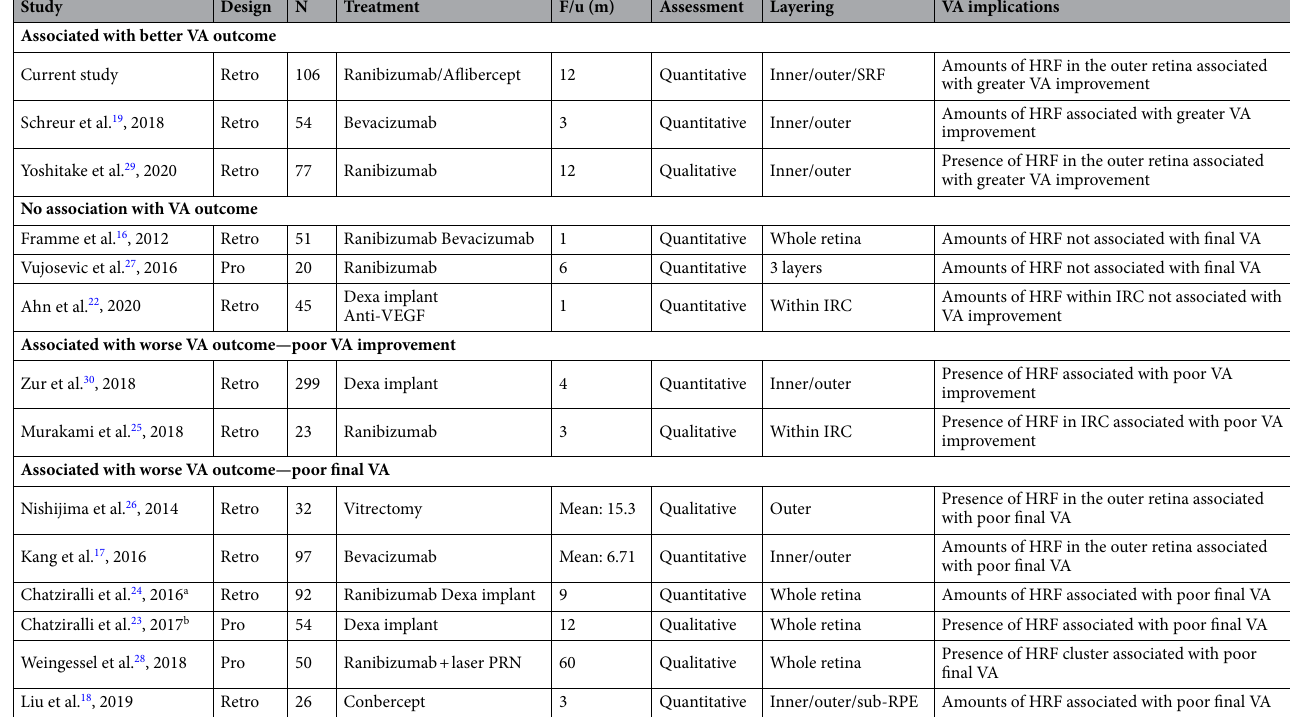
Table 3. Studies evaluating the role of baseline hyperreflective foci in predicting visual outcomes after treatment for diabetic macula oedema. N case number, F/u follow-up interval (months), VA visual acuity, Retro retrospective, Pro prospective, IRC intraretinal cyst, Dexa implant dexamethasone implant, HRF hyperreflective foci, SRF subretinal fluid, VEGF vascular endothelial growth factor, RPE retinal pigment epithelium, PRN pro re nata. a This study included macula oedema resulted from diabetic retinopathy and retinal vein occlusion. b This study included diabetic macular oedema patients refractory to anti-VEGF